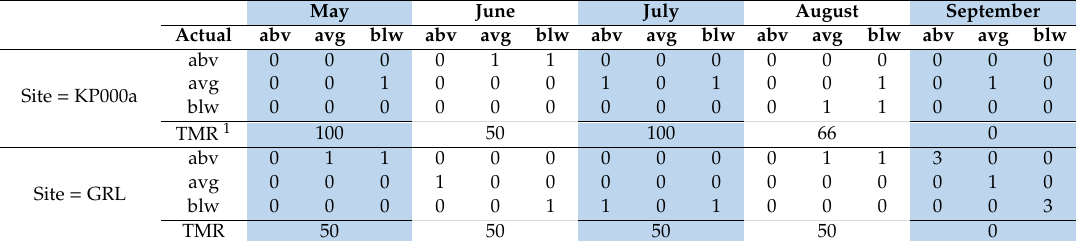
Table 2. Discriminant analysis within-site validation confusion matrices showing actual and predicted class membership for the months May through September for both sites. AGFM classes are above average (abv), average (avg), and below average (blw) above-ground forage biomass. The total misclassification rate (TMR) for each month is also shown, and is calculated as the number of misclassifications divided by the total number of